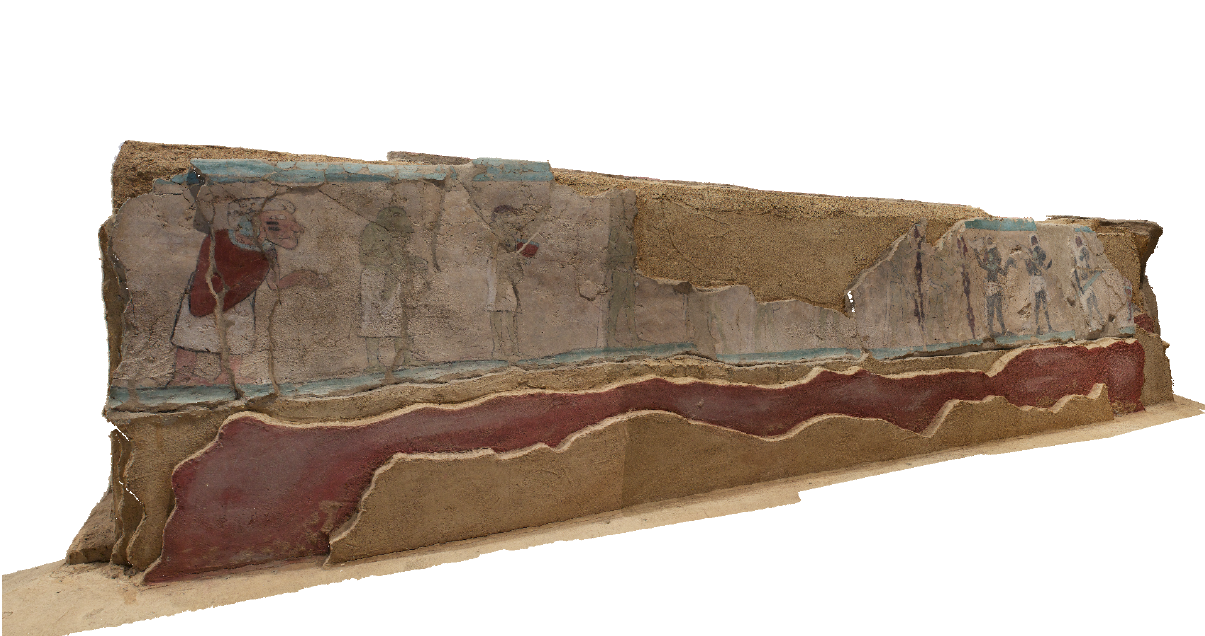
Figure 7. 3D model of the south lower